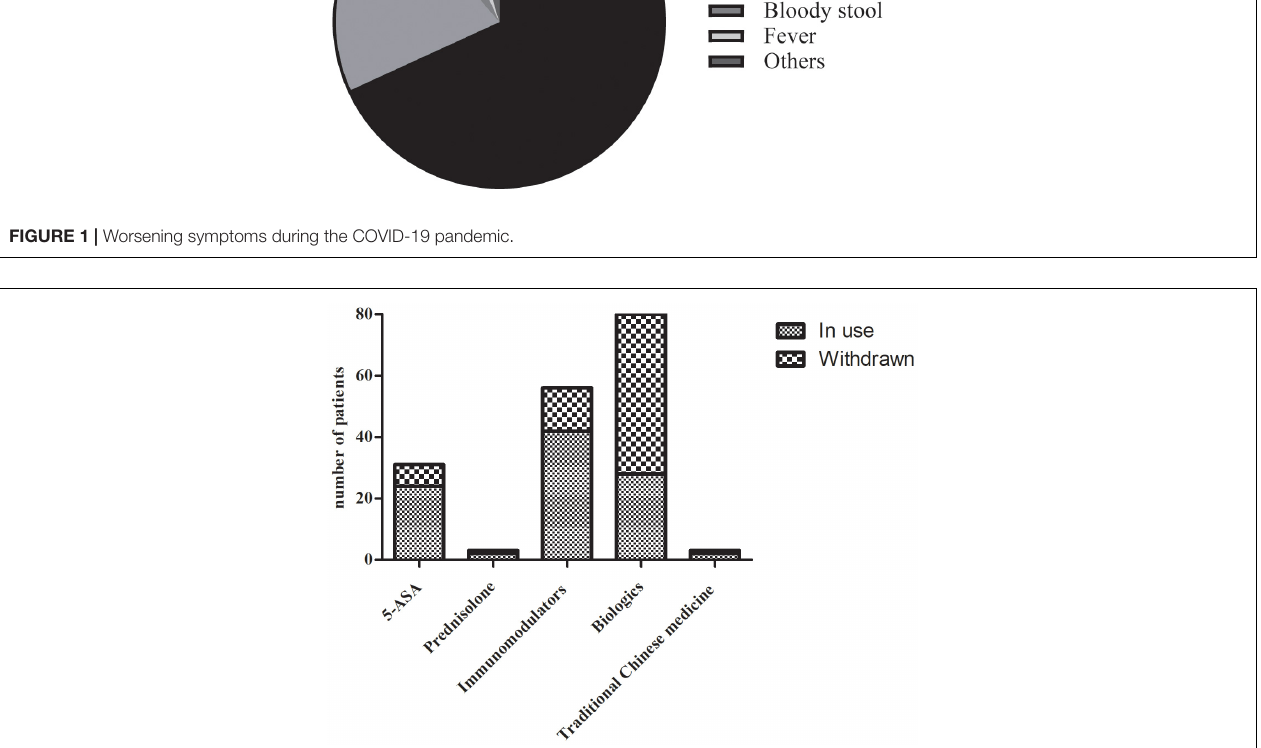
FIGURE 2 | Rates of drug withdrawn for different medications. 5-ASA, 5-aminosalicylic acid.